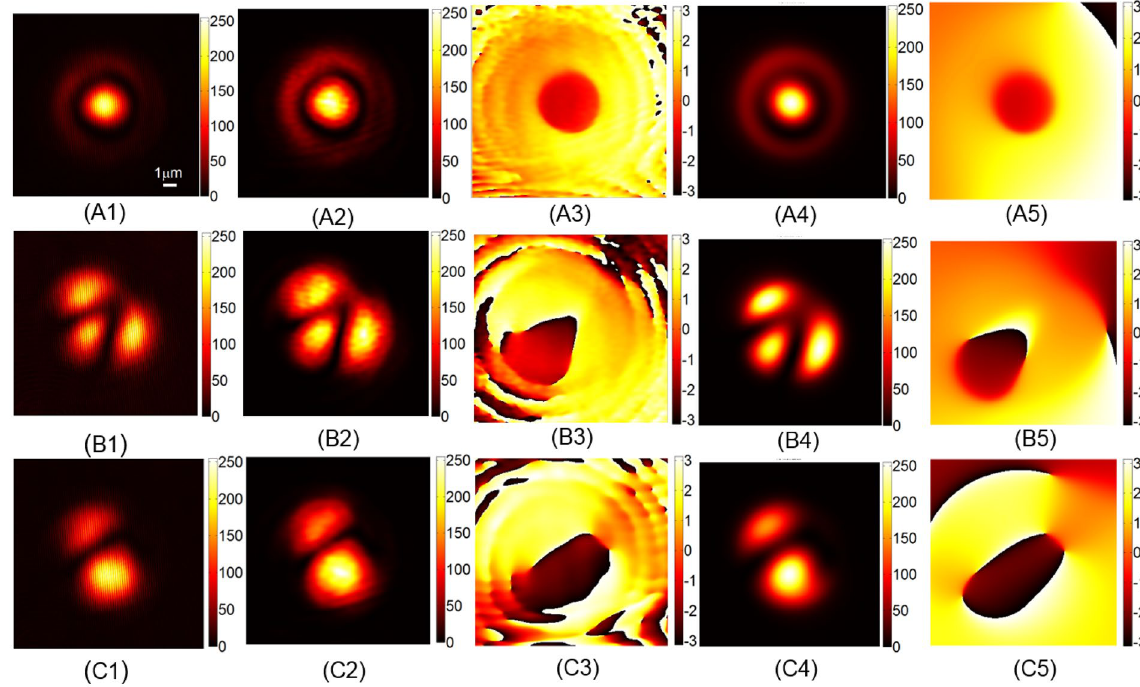
Figure 2. Modal decomposition results of the communication fiber. ( A1 , B1 and C1 ) The holograms recorded by the camera. The ratio of the average power density between the object beams and the reference beams is about 5:1. ( A2 , B2 and C2 ) The intensity patterns reconstructed from the holograms. ( A3 , B3 and C3 ) The phase maps reconstructed from the holograms. ( A4 , B4 and C4 ) The intensity patterns synthesized by modal coefficients. ( A5 , B5 and C5 ) The synthesized phase